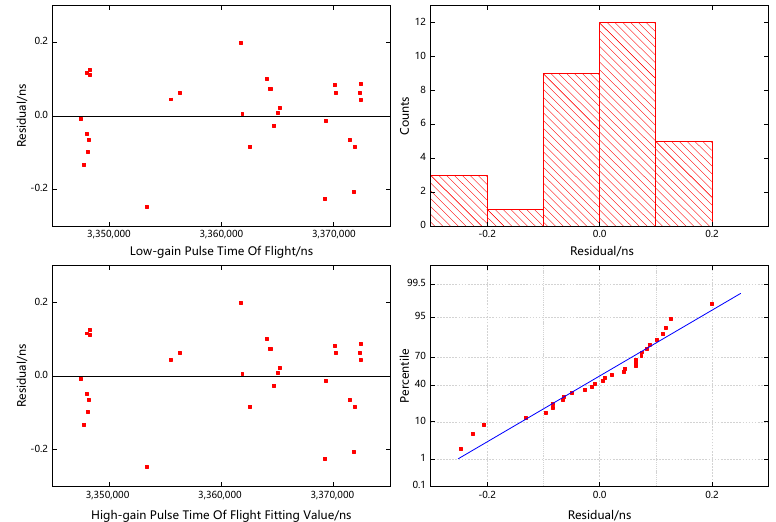
Figure 11. Residual plots of the high- and low-gain TOF fitting, which are composed of the residual plot with the independent variable as abscissa ( upper left ), the residual plot with the fitted value of the dependent variable as abscissa ( lower left ), the histogram of the residuals ( upper right ), and the normal probability plot of the residuals ( lower right ).